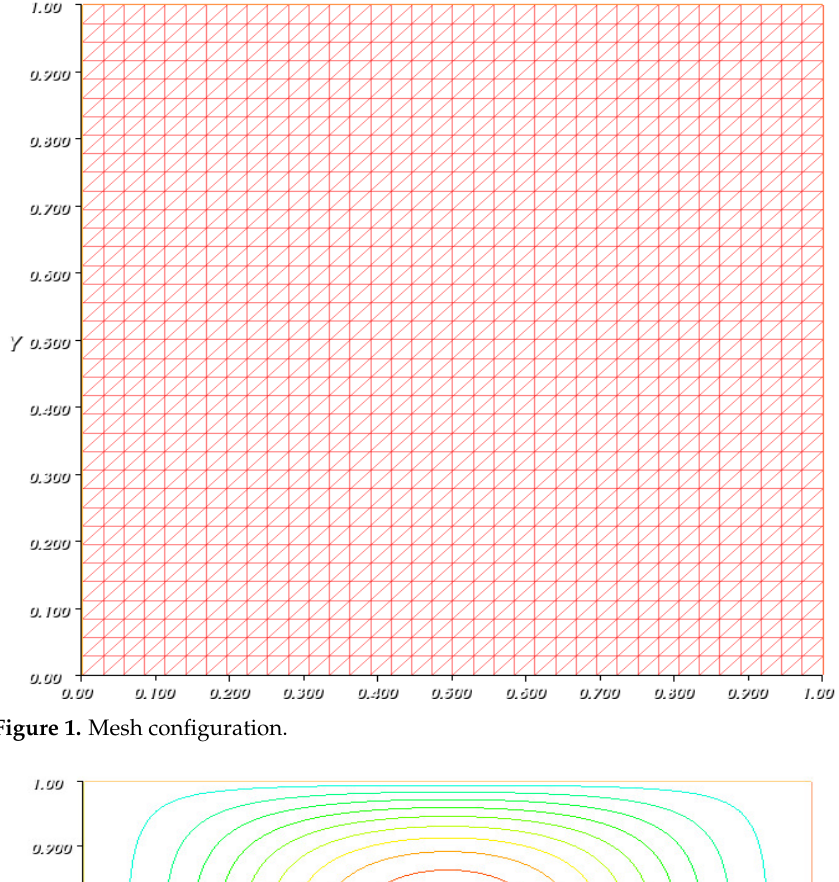
Figure 1. Mesh configuration.